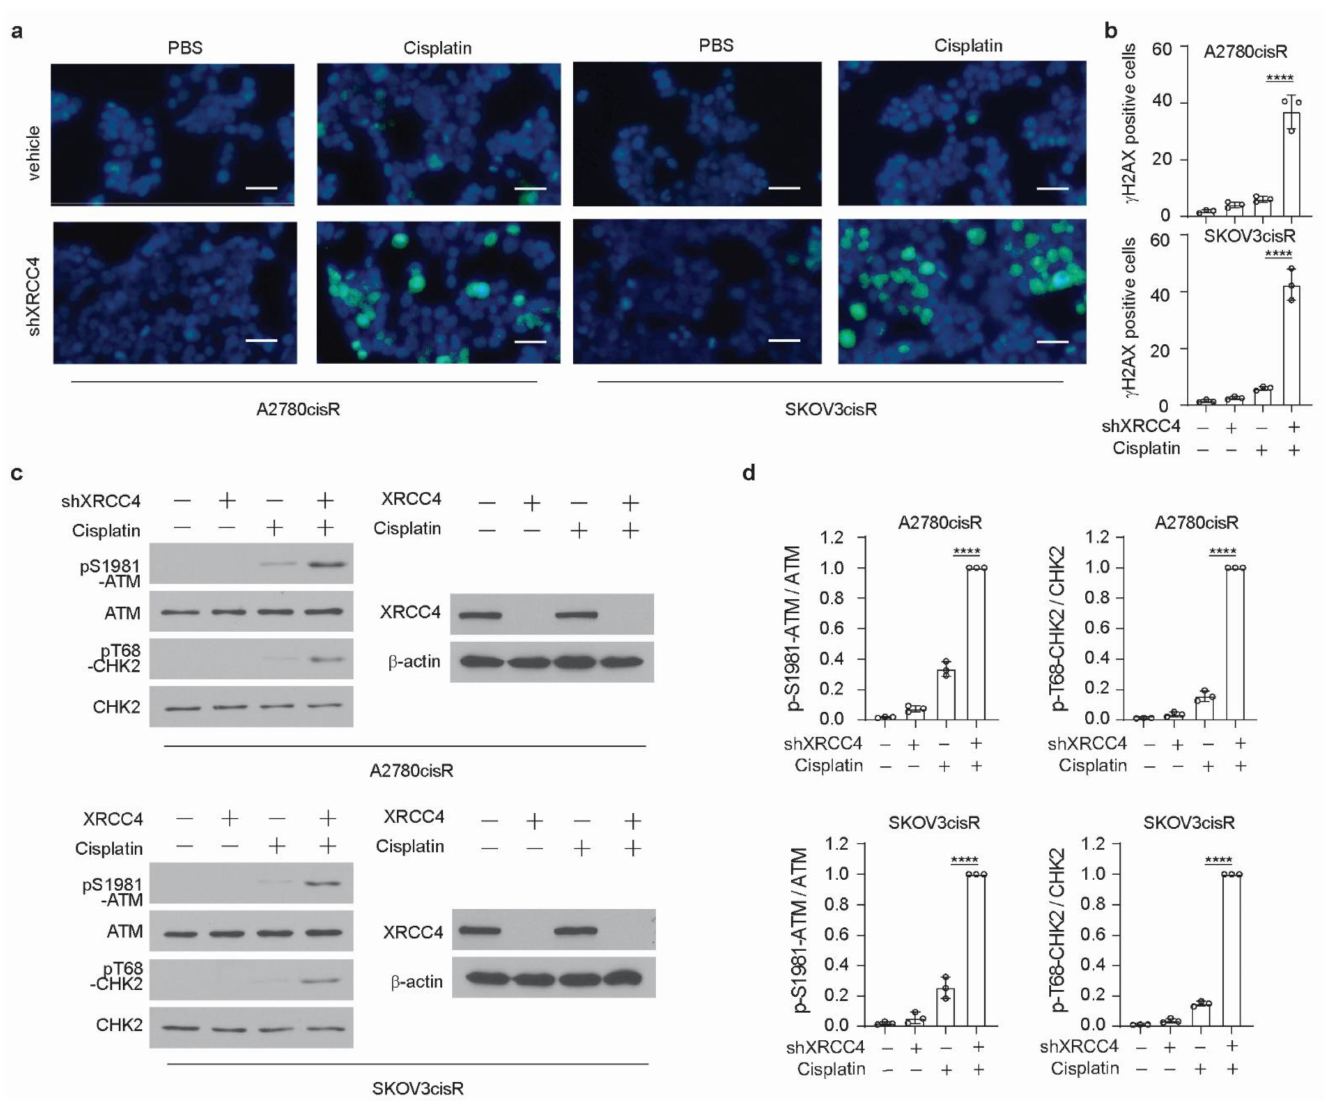
Figure 3. XRCC4 loss significantly induced DNA damage in cisplatin-resistant ovarian cells upon cis- platin treatment. ( a , b ) Representative immunofluorescence staining ( a ) of γ H2AX (green) and DAPI (blue) and related quantification ( b ) in the indicated cells (treatment: cisplatin, 5 µ g/mL A2780cisR, and 2 µ g/mL SKOV3cisR for 48 h). Percentages of γ H2AX-positive cells were quantified and are shown in the bar plots separately. Scale bar, 100 µ m. ( c , d ) Representative blot ( c ) and quantification ( d ) of DNA damage checkpoint proteins in the indicated cells by Western blot (treatment: cisplatin, 5 µ g/mL A2780cisR, and 2 µ g/mL SKOV3cisR for 24 h). Indicated protein expression levels were quantified by ImageJ and are shown in the bar plots separately. Data are mean ± SD from 3 technical replicates of each sample and are representative of 2 ( a ) and 2 ( c ) independent biological experiments. Statistical analysis was performed by 1-way ANOVA for all data (**** p <